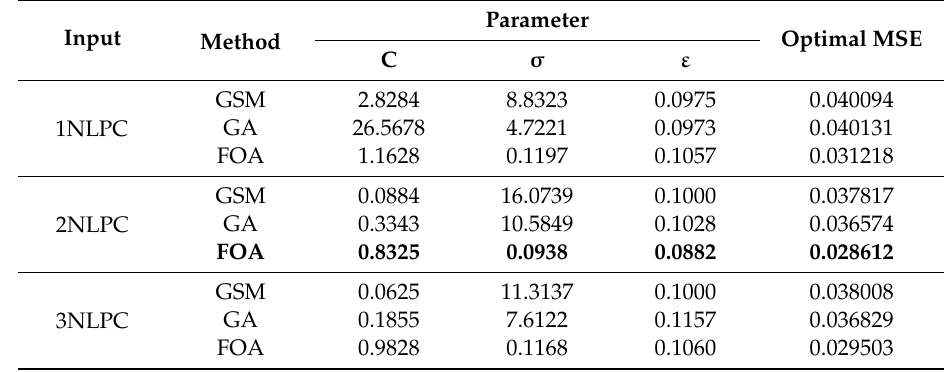
Table 2. Optimal results of the NLPCA-SVR model.